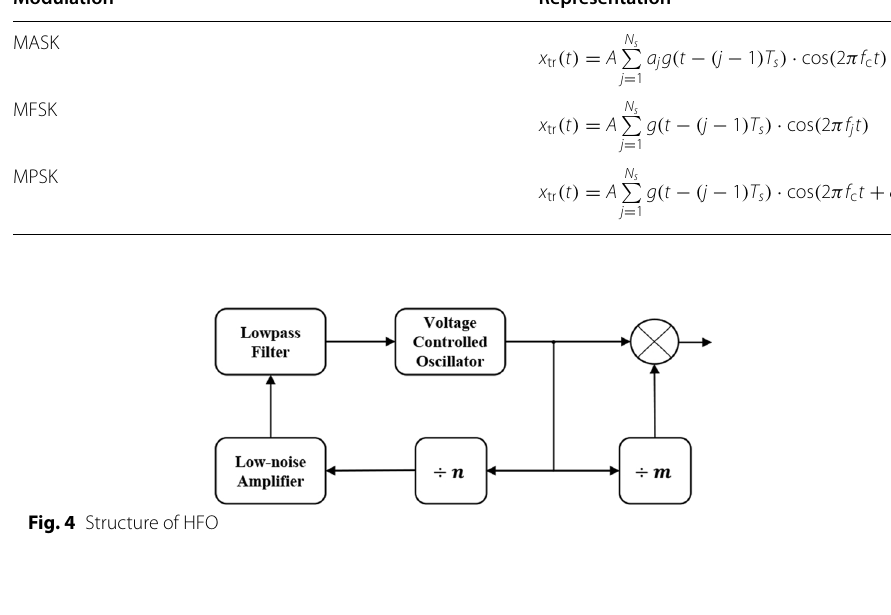
Table 2 Representation of modulated signals Modulation